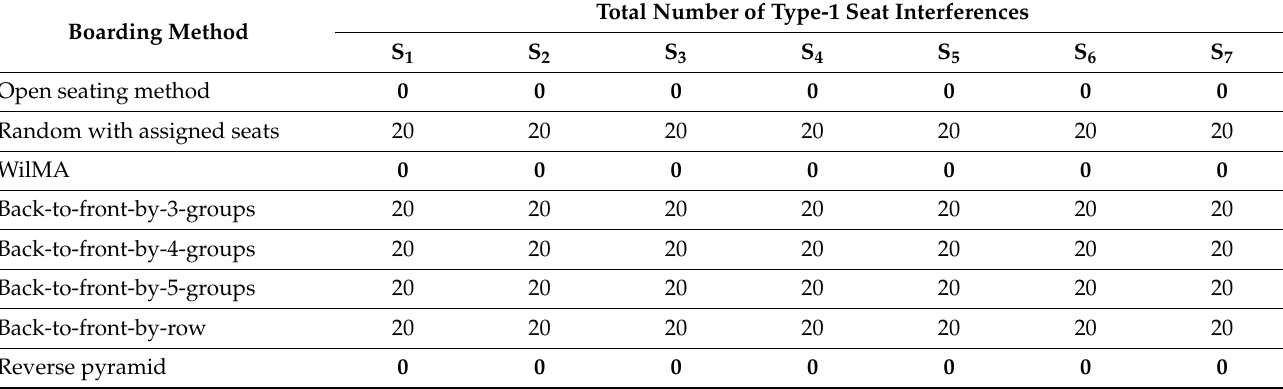
Table 6. Total number of type-1 seat interferences.